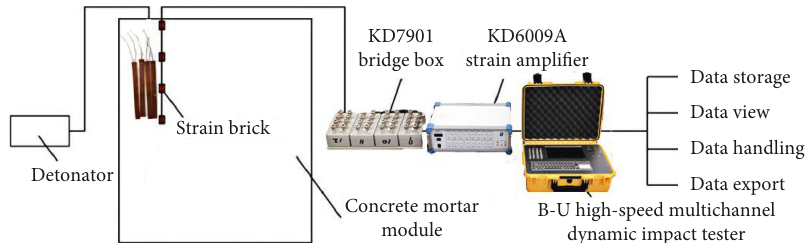
Figure 3: Stress-monitoring test system.